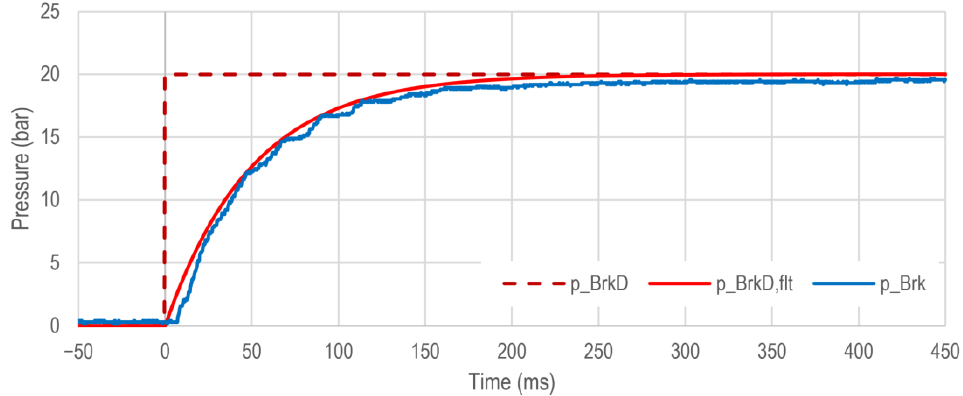
Figure 9. Pressure build-up dynamics in the vehicle wheel brake of the HiL test bench in the event of a step in the desired pressure.